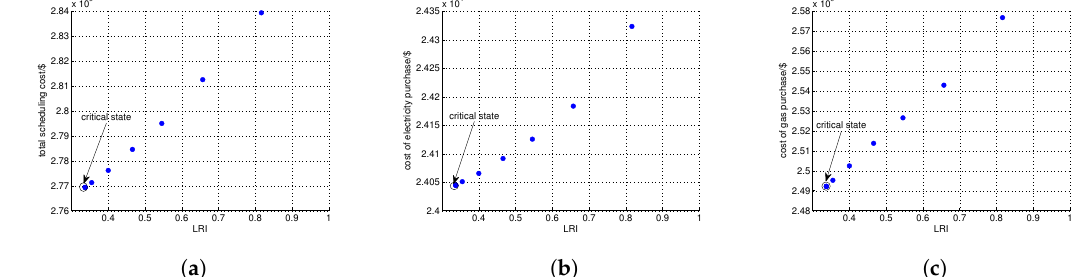
0.4 0.5 0.6 0.7 0.8 0.9